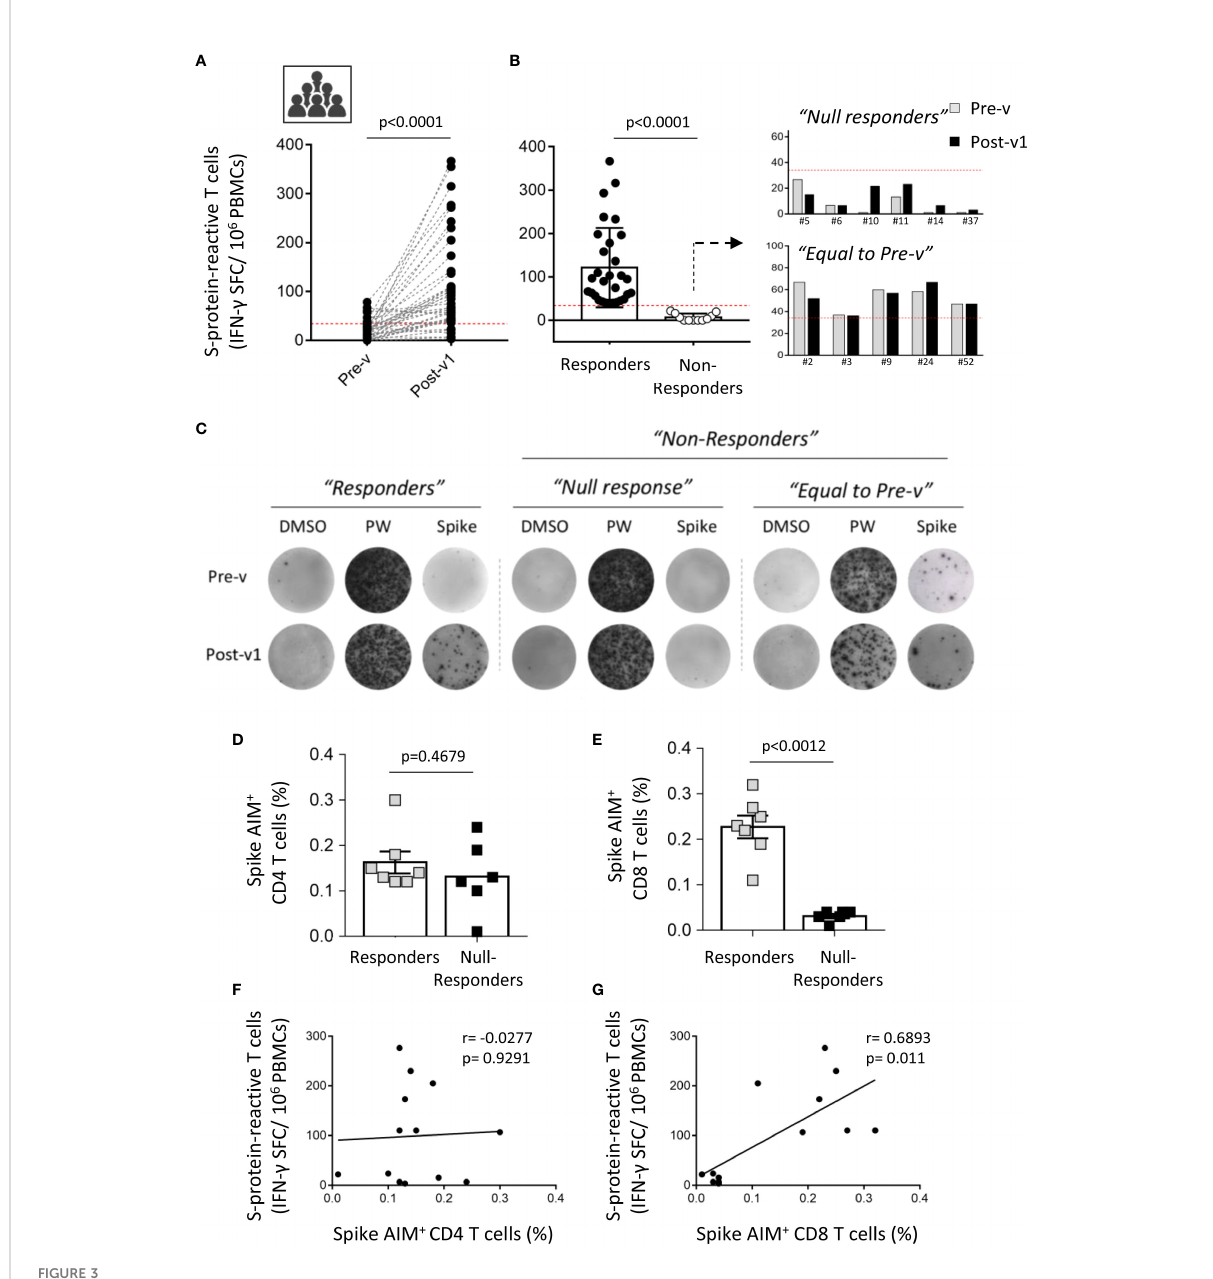
FIGURE 3 Interindividual variation of the cellular immune response to SARS-CoV-2 after COVID-19 mRNA vaccination. (A) Paired graph showing the number of speci fi c T cells reactive against the S protein was evaluated by ELISpot assay in PBMCs from ICU workers (n=41) obtained before vaccination (Pre-v) and 1 month (Post-v1) after full vaccination. Statistical comparisons were performed by Wilcoxon test. (B) Frequency of spike-speci fi c T cells detected by ELISpot assay in samples with a positive response ( “ Responders ” ) o those with a null response ( “ Non- responders ” ). The latter were divided in “ Null responders ” when the number of speci fi c T cells was below the cut-off (<33.3 SFCs/10 6 PBMCs) and “ Equal to Pre-v ” when the number of speci fi c T cells is not enhanced after vaccination. (C) Representative images of IFN- g -inducing spots in “ Responders ” and “ Non-responders ” groups. (D, E) Percentage of spike AIM + CD4 + and CD8 + T cells in seven individuals from “ Responders ” group and six samples that lack of cellular response to SARS-CoV-2 ( “ Null responders ” group). Statistical comparisons were performed by two tail Mann Whitney test. (F, G) Correlation between frequencies of spike AIM + CD4 + and CD8 + T cells and the number of spike-reactive T cells evaluated by ELISpot assay in the individuals corresponding to “ Responders ” (n=7) and “ Null responders ” (n=6) groups. Statistical was performed by Spearman correlation coef fi